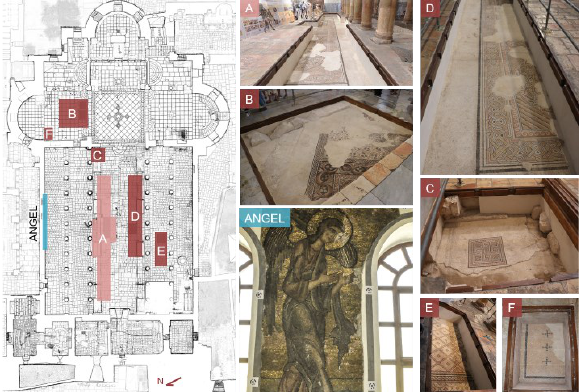
Figure 3. Floor and wall mosaics documented. The color indicates the different campaigns: blue 2014, pink January 2019 and red August 2019